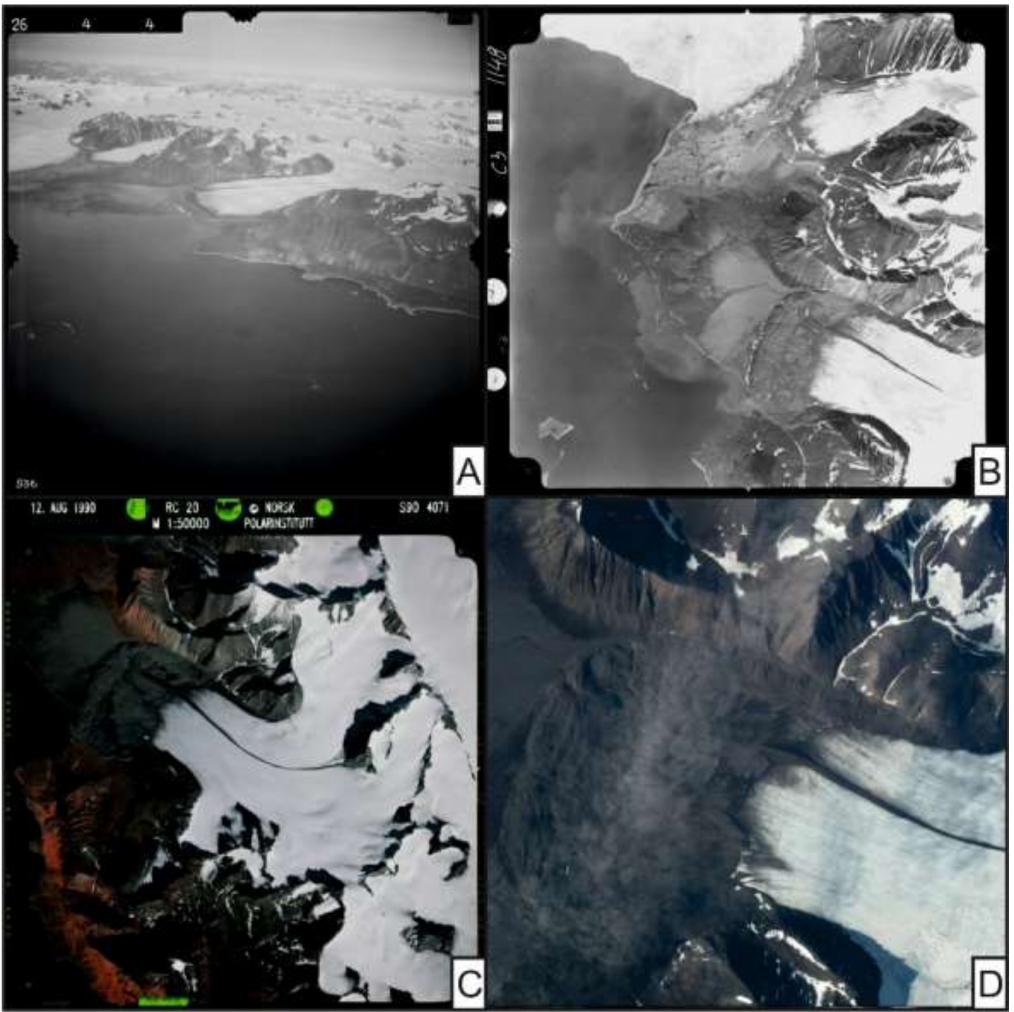
Figure 2. Examples of source photographs of the Werenskiold Glacier: ( A ) black and white oblique photograph from 1936; ( B ) black and white orthogonal photograph from 1960; ( C ) color orthogonal photograph from 1990; ( D ) color orthogonal image from 2011